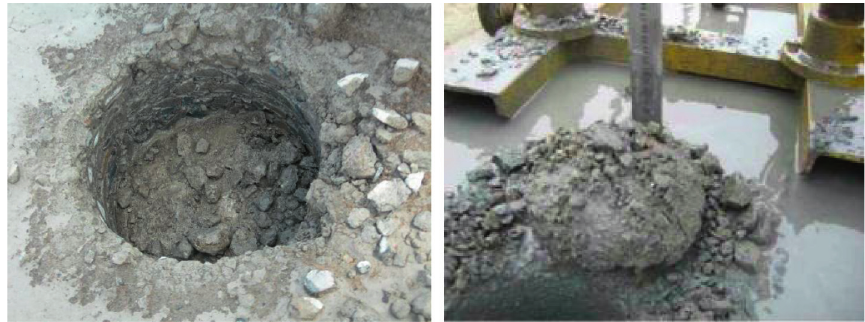
Figure 9: Coring loose picture.